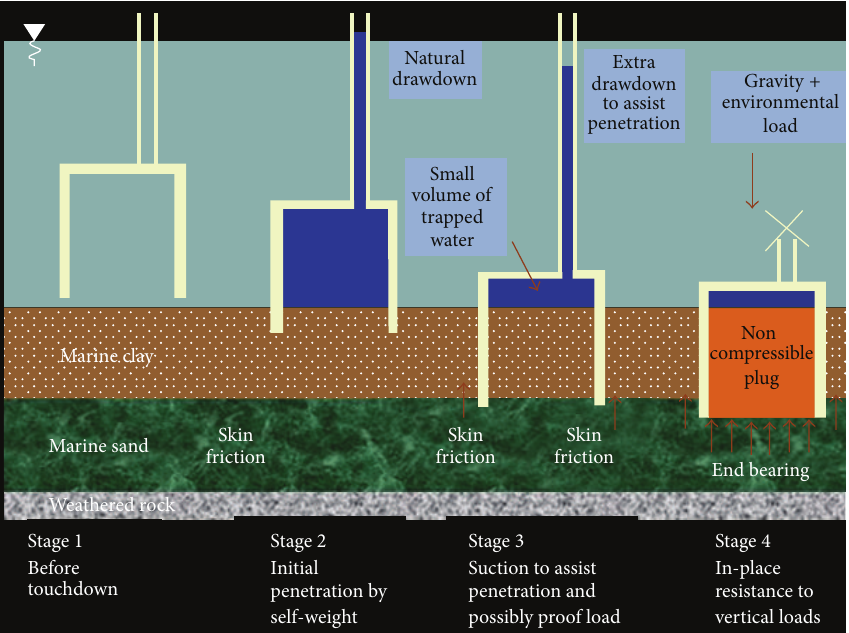
Figure 4: Suction caisson foundation installation stages [6].